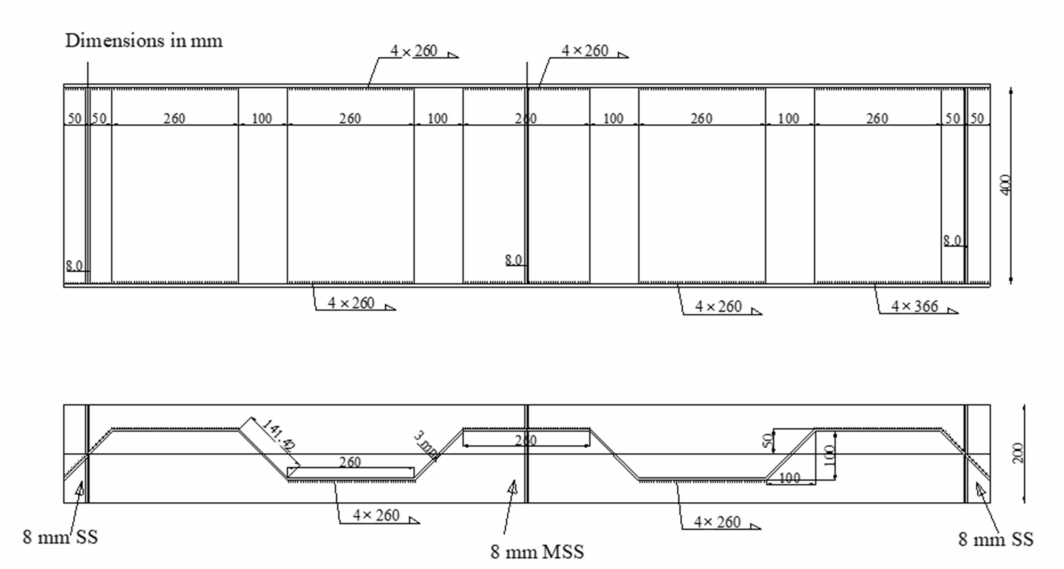
Figure 4. Details of the corrugated-web specimens